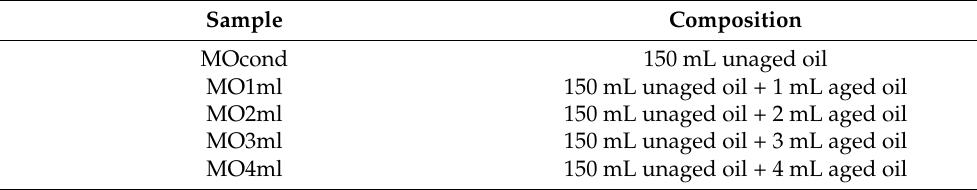
Table 1. Measured mineral oil samples.